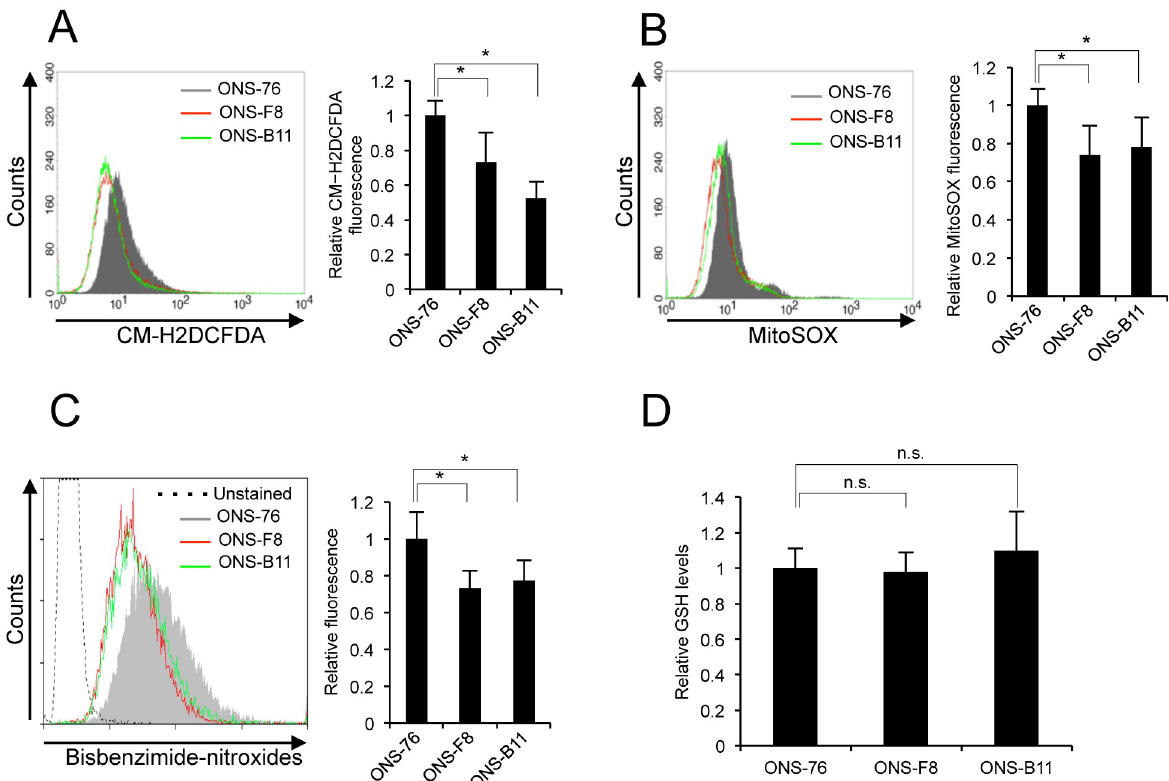
Fig 1. ONS-F8 and -B11 showed low levels of ROS and nuclear oxidative stress. Levels of (A) intracellular ROS, (B) mitochondria- derived superoxide, (C) nuclear oxidativestress, (D) GSH in ONS-76, -F8 and -B11. All quantitative data are means ± S.D. * P < 0.05, Welch’s t-test, n.s.,